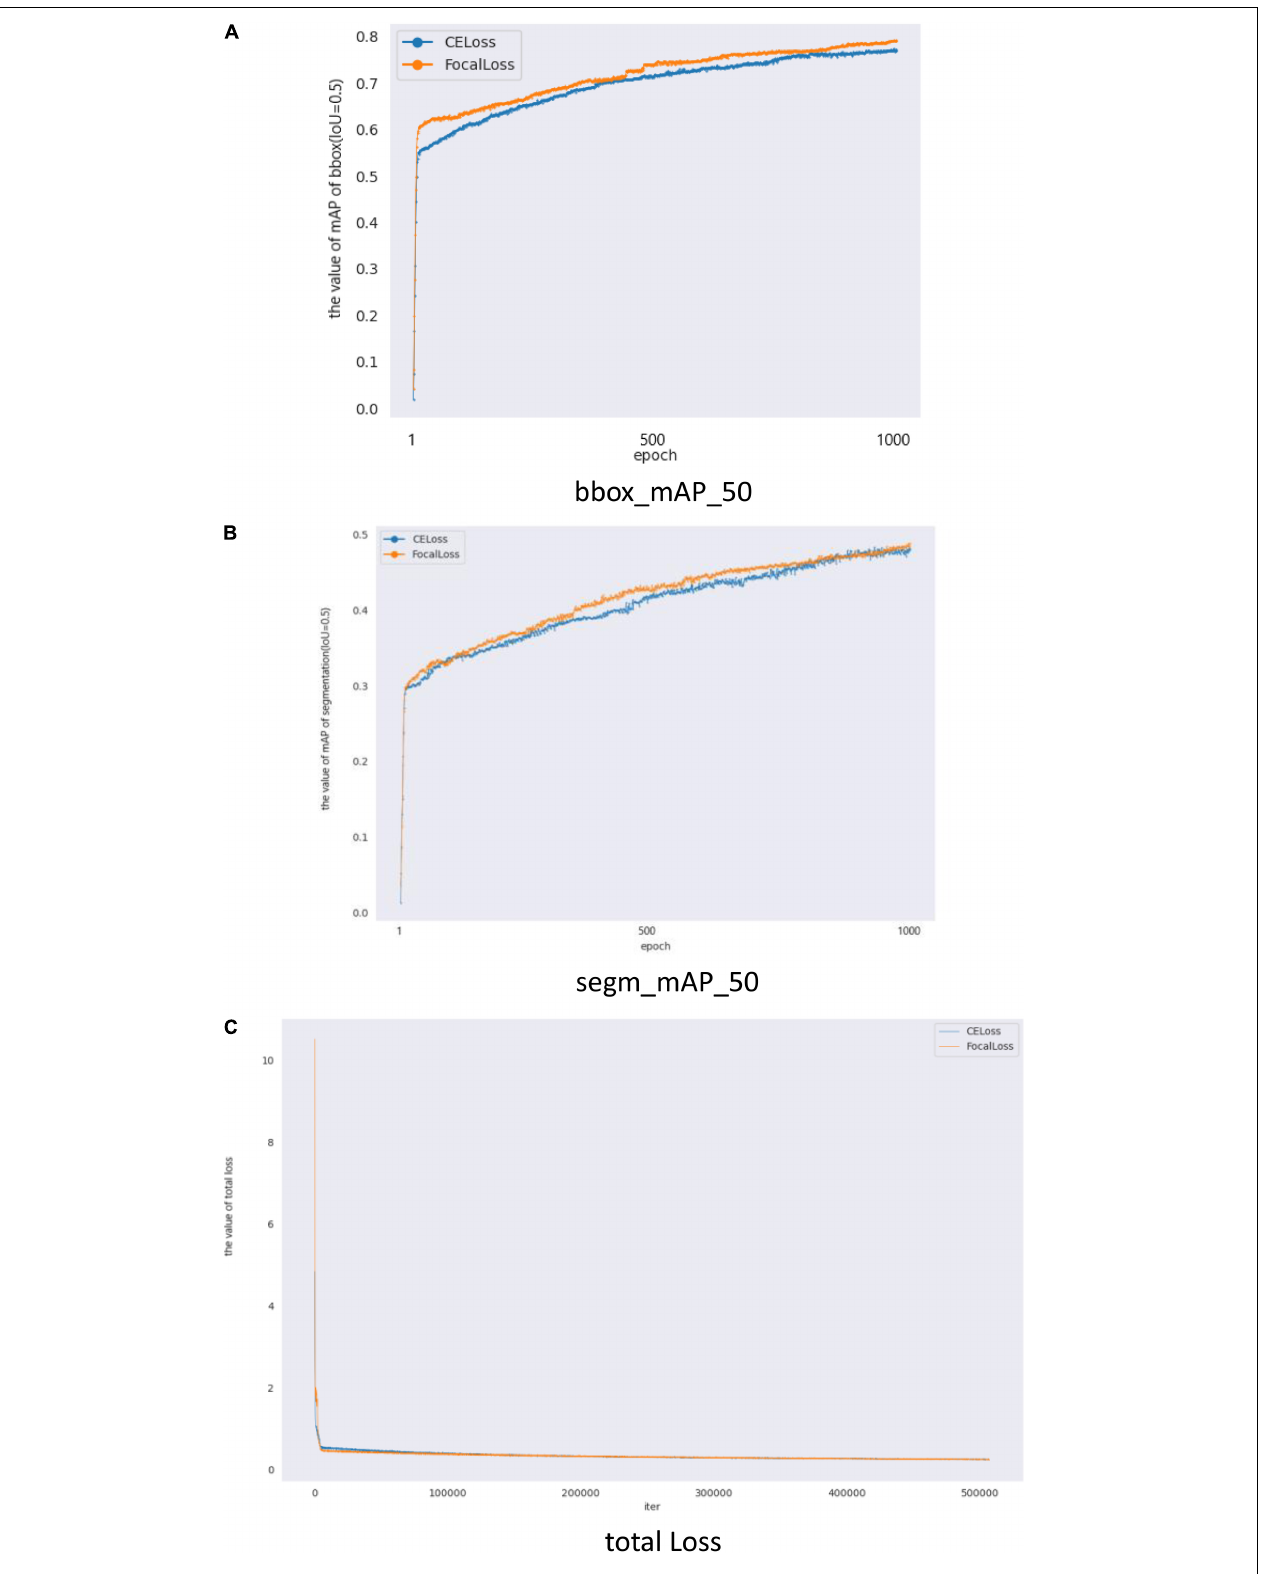
FIGURE 6 | Mask R-CNN with different loss validation parameters and loss functions. (A) Comparison of mAP_50 of bbox (IoU = 0.5) on different loss, (B) Comparison of mAP_50 of segmentation (IoU = 0.5) on different loss, and (C) Comparison of total loss.